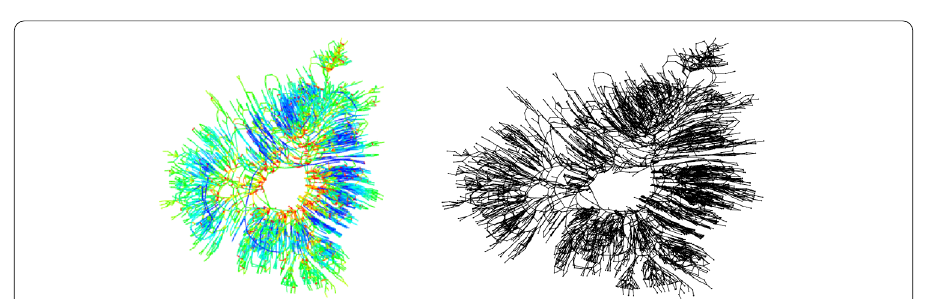
Figure 5 USpowerGrid, left: result from [14], right: our result